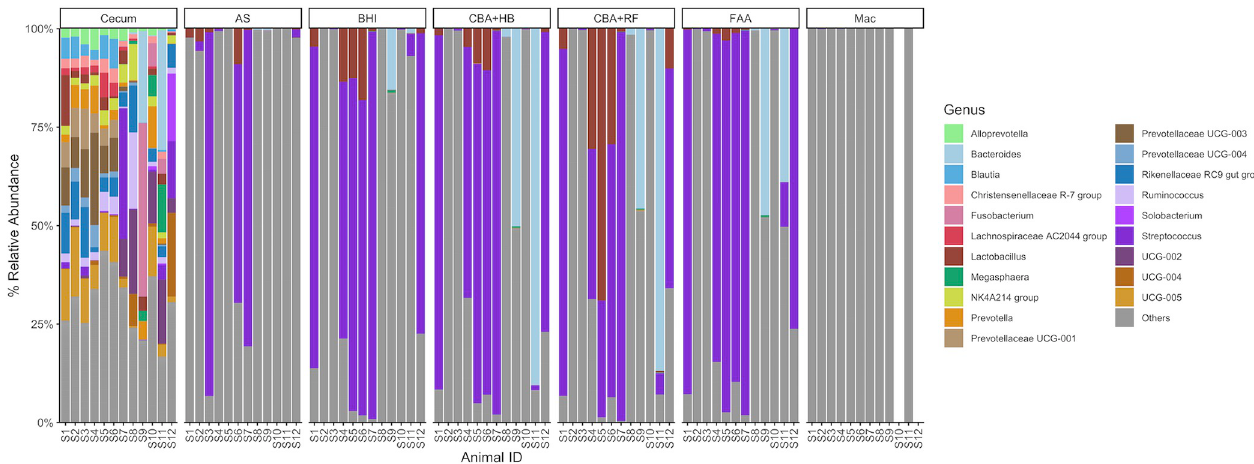
Fig 7. Relative abundance of genus in culture-derived and cecum samples. Abbreviations: MacConkey agar (Mac), fastidious agar with horse’s blood added (FAA), Columbia agar with horse’s blood added (CBA+HB), Columbia agar with rumen fluid added (CBA+RF), BHI3 with carbohydrate added (BHI), AS (samples plated on CBA+HB after alcohol shock), and Cecum (samples sequenced directly, without culture). Healthy horses: S1-S6. Acute typhlocolitis horses: S7-S12.